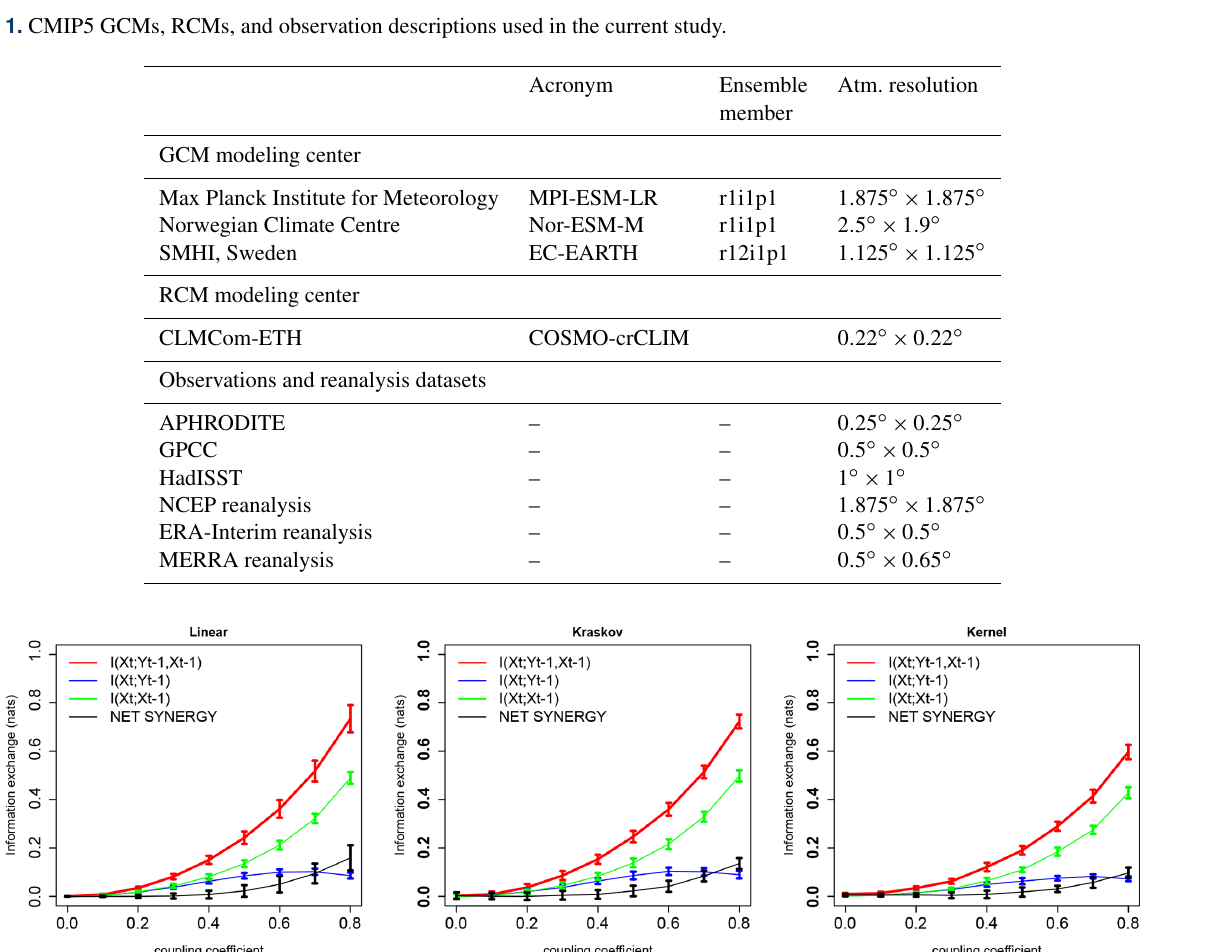
estimator (40 k -nearest neighbors) and kernel estimator (a kernel width of 1.5), also show similar system behavior. The free parameters, i.e., kernel width (a kernel width of 1–2) and the number of k -nearest neighbors (20–60 neighbors), are tested and tuned for consistent and robust